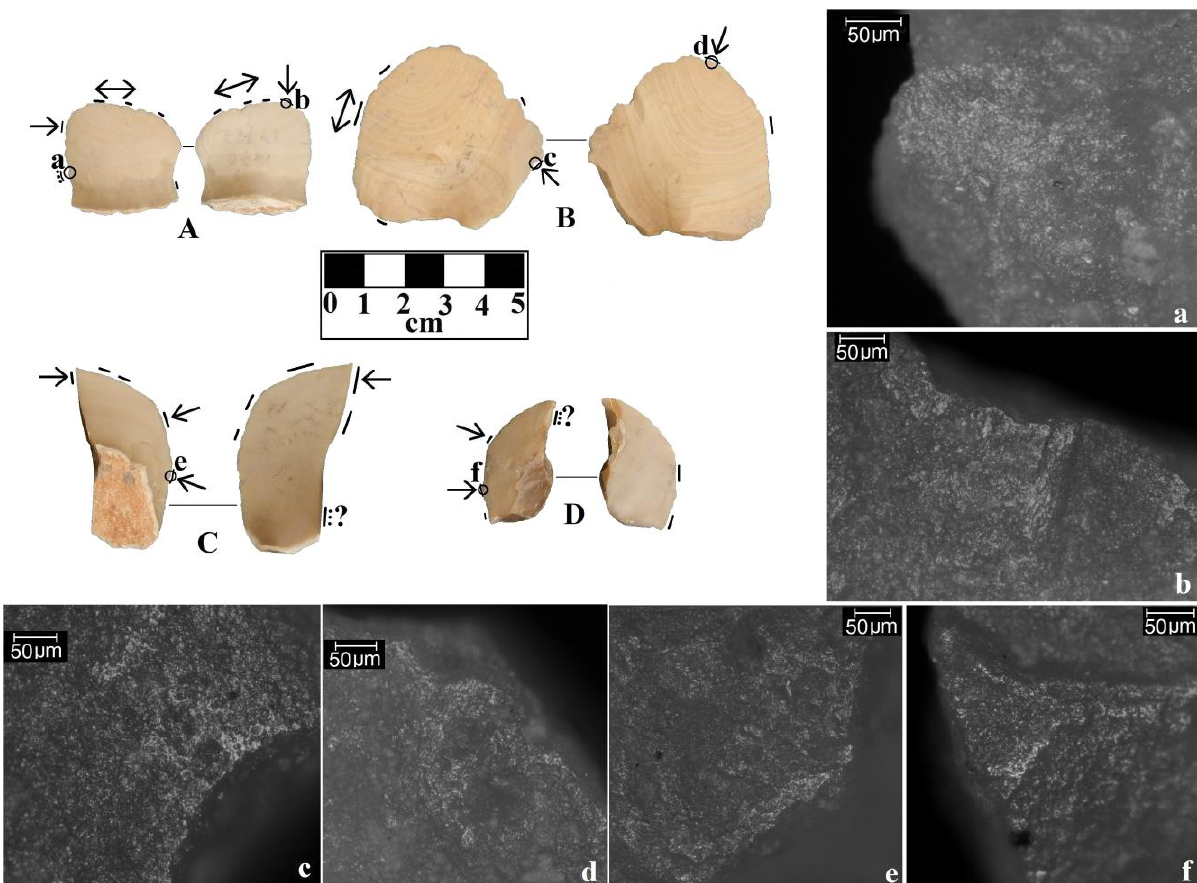
Figure 7. Dorsal (left) and ventral (right) faces of regular ( A , B ) , Tabun snap ( C ) and Kombewa ( D ) type blanks from WR layers at Ein-Zippori used to cut or scrape meat or soft wood ( A & B ) or work wood ( C & D ). White lines show the extent of the usewear traces, arrows show orientation of the microwear polishes and striations, line with dots shows possible prehension traces. White circles show locations of photomicrographs a , b , c , d , e , and f . A : Area C, Locus 1970, Bucket 17722. Cortext on proximal end. B : Area C, Locus 1996, Bucket 90038. C : Area C, Locus 1996, Bucket 90071. Cortex covers one third of the dorsal face. D : Area C, Locus 1999, Bucket 17935, lustrous. a : Prehension traces on proximal left lateral edge (dorsal) of A . b : Bright wood polish and duller meat polish on distal edge (ventral) of A . Edge-Angle is 25ᵒ. c : Bright wood polish on right lateral edge (dorsal) of B . d : Rough meat polish on distal edge (ventral) of B . At c and d , E.A. is 20ᵒ. e : Bright wood polish normal to right lateral edge (dorsal) of C . E.A. is 45ᵒ. f : Bright wood polish and striae on left lateral edge (dorsal ) of D . E.A. 45ᵒ. Possible prehension traces were also visible on C and D . All photomicrographs 187.5x, with scales that are 50